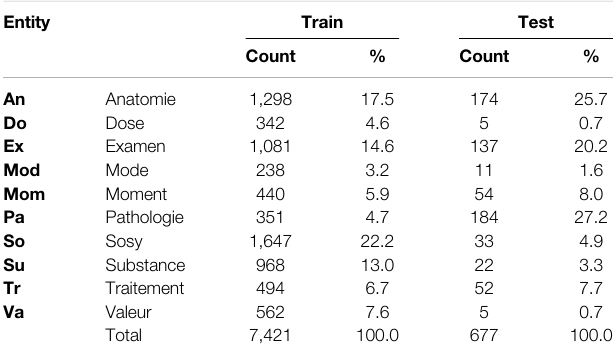
TABLE 2 | Entity distribution in the of fi cial training and test sets of the DEFT benchmark dataset. Entity